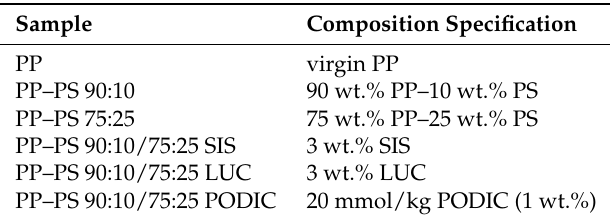
Table 1. Blend composition and specification.